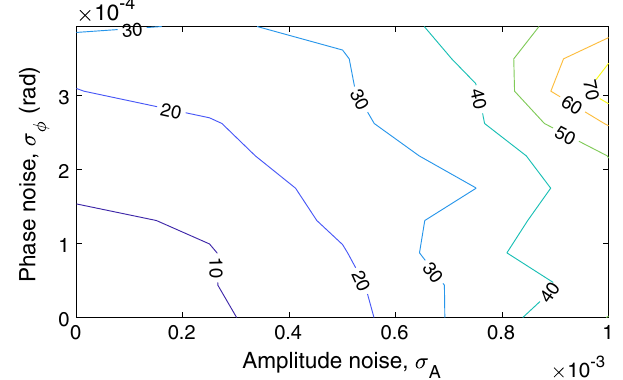
FIG. 8. Projected emittance (pm) of the regular bunches due to high frequency rf noise (modeled as white noise) in crab cavities (with V 1 ¼ 1 MV) vs levels of rf phase and amplitude noise. Emittance due to linear coupling, with a coupling ratio of 0.06%, and the effect of a 10-ps phase shift (see next subsection) are